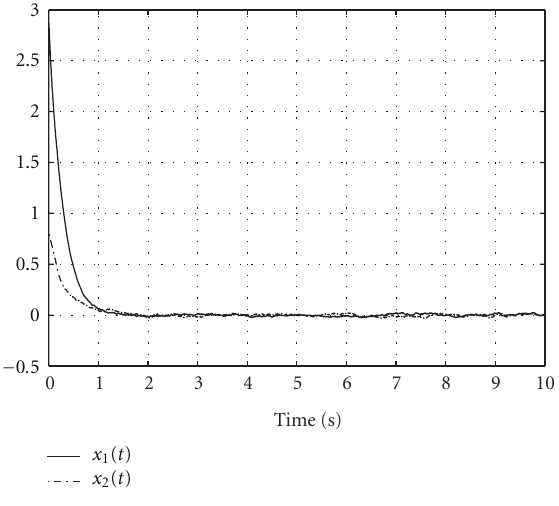
Figure 1: Responses of the state vector x ( t